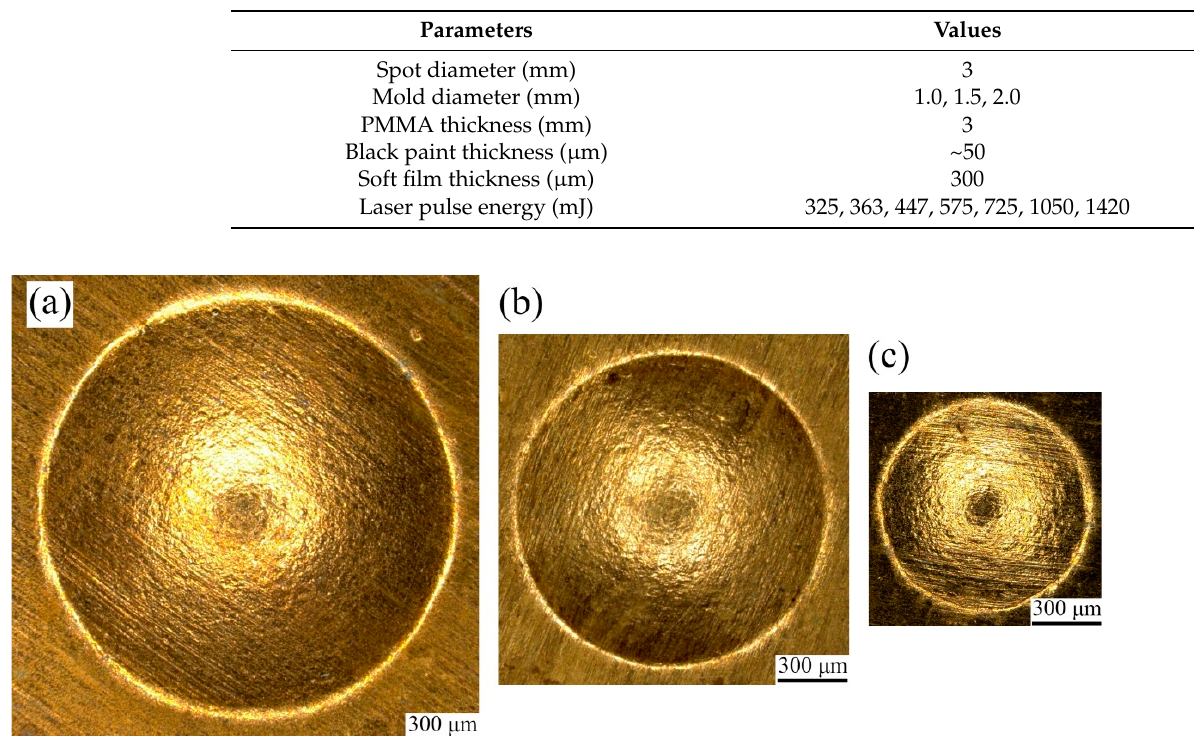
Figure 5. Topography of coarse ‐ grained bulging samples under laser pulse energy of 363 mJ. ( a ) λ = 1 ( b ) λ = 0.5 ( c ) λ = 0.25. 3. Results and Discussion 3.1. Forming Depth The maximum depth of the bulging area is defined as forming depth in this section, and five bulging samples were measured under each experimental condition to obtain the average forming depth. Figure 6 shows the influence of mold characteristic size on form ‐ ing depth of bulging samples under different grain sizes and laser pulse energies. It can be found that the forming depth increases with the increase of laser energy. Specifically, when the laser energy increases from 325 to 575 mJ, the forming depth of bulging samples annealed at 450 °C without LPS increases from 223.2 to 367.7 μ m. In addition, the variation trends of forming depth of both coarse ‐ grained and fine ‐ grained samples are similar un ‐ der the same mold characteristic size. The forming depth of bulging samples increases with the increase of scale factor λ . Specifically, when the laser energy is 363 mJ, the form ‐ ing depths of fine ‐ grained bulging samples without LPS fabricated by three bulging molds are 250.0 μ m, 395.6 μ m and 575.5 μ m, respectively. Large mold characteristic size is con ‐ ducive to enhancing the micro ‐ forming ability of the workpiece [24]. The forming depth of bulging samples is small because the plastic deformation of copper foil is dominated by slip when λ = 0.25. The reduction of mold characteristic size means that the number of grains and grain boundaries in the bulging zone are reduced, which leads to the reduction of flow stress [25]. The deformation coordination ability between grains is reduced,